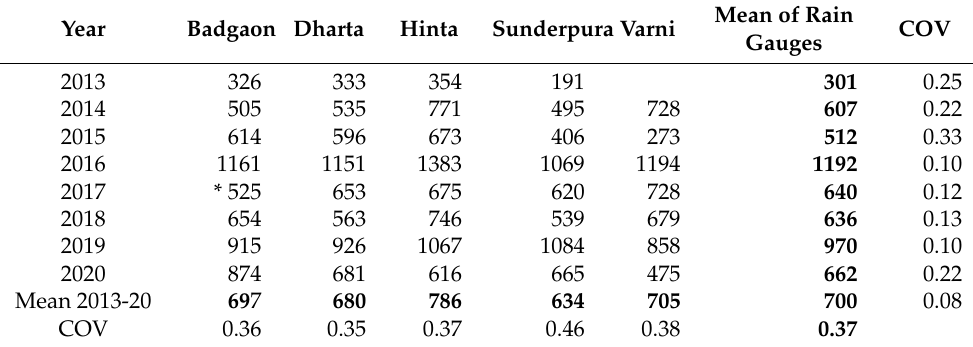
Table 1. Monsoonal rainfall (in millimetres) for five daily-read rain gauges in the Dharta catchment for the monsoons from 2013 to 2020. The average of all five stations in shown in